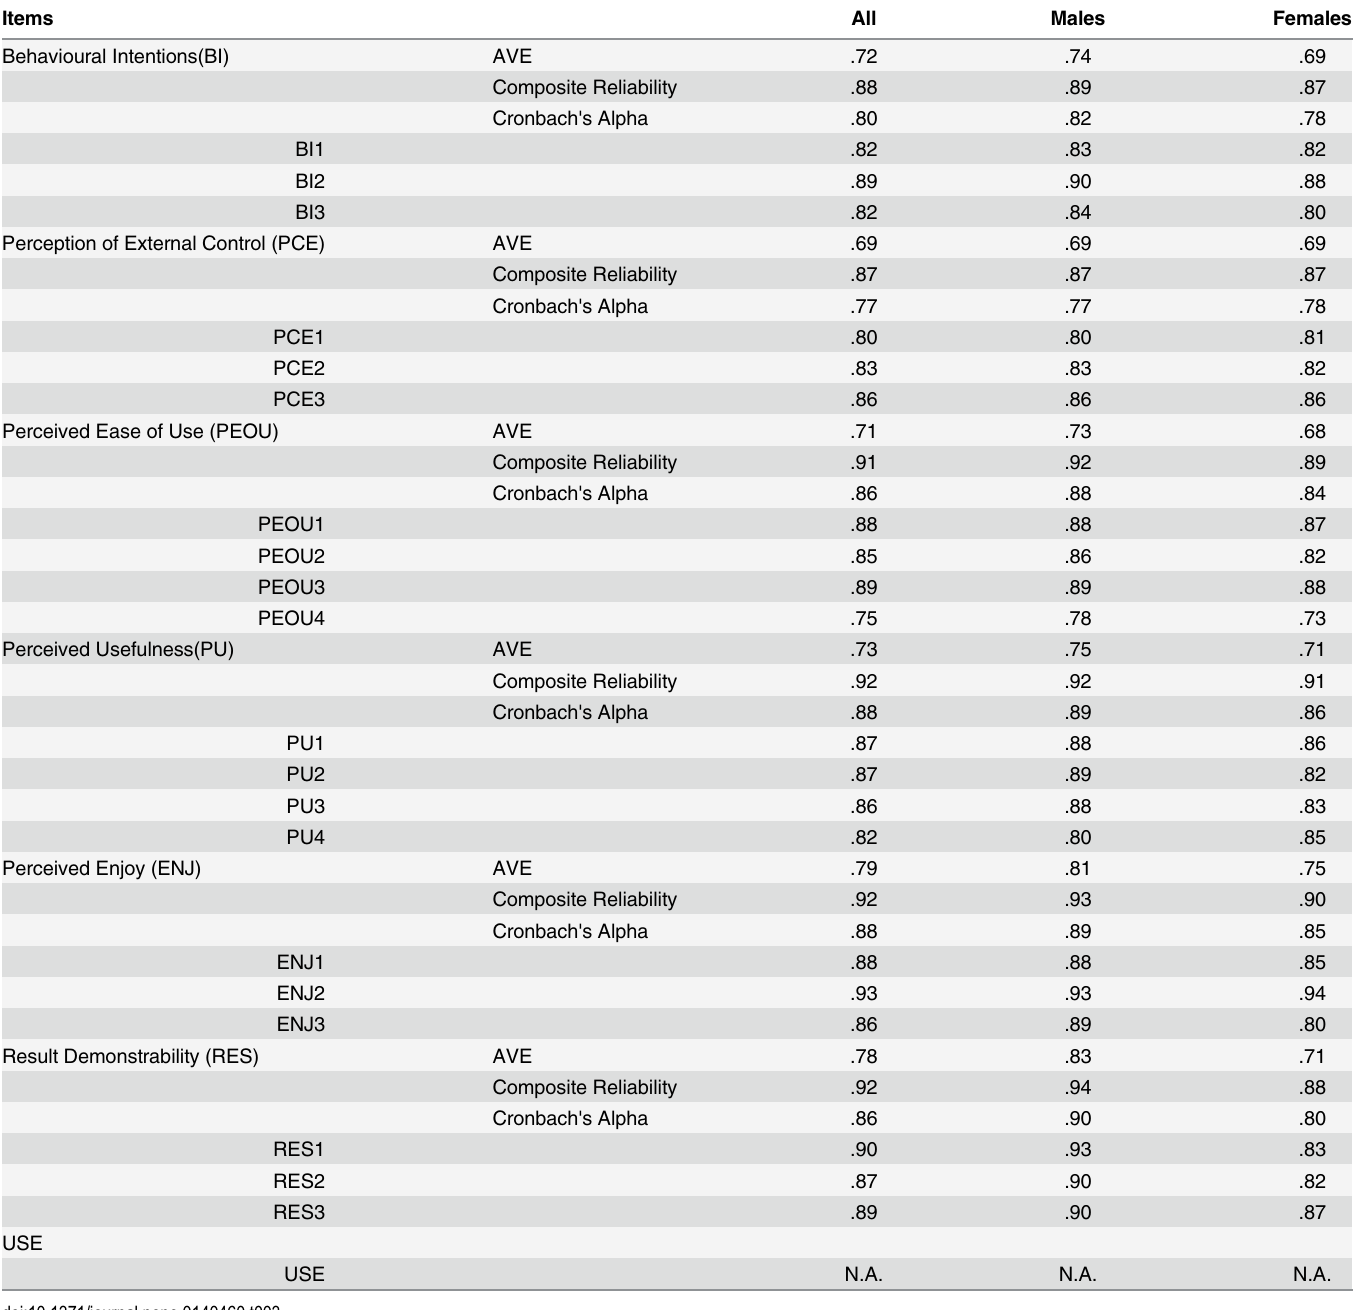
Table 3. Cronbach ’ s Alpha, AVE, Composite Reliability and Factor